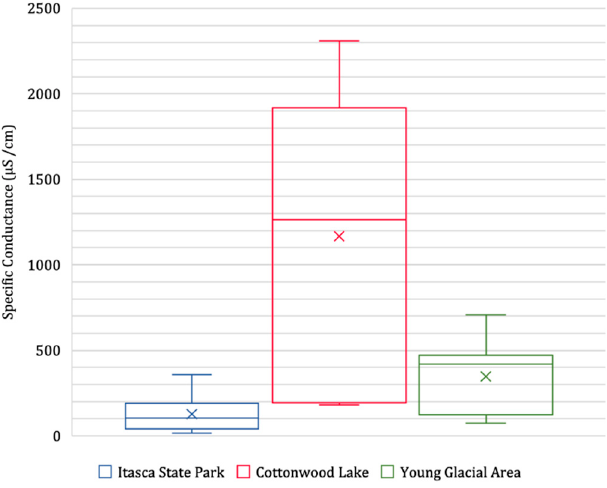
Figure 14. Specific conductance measurements for the Cottonwood Lake area (North Dakota) [12], Young Glacial Area (northern Poland) [13], and Itasca Moraine (this study) using averaged values for the types of ponds and lakes sampled. In the plots, the x symbol represents the mean, the middle bar the median, the upper box the third quartile, the lower box the second quartile, the upper whisker the fourth quartile and the maximum, and the lower whisker the first quartile and the minimum. The gaining lakes at the Poland site are the most mineralized, the flow-through lakes have intermediate mineralization, and the losing lakes have the least mineralization